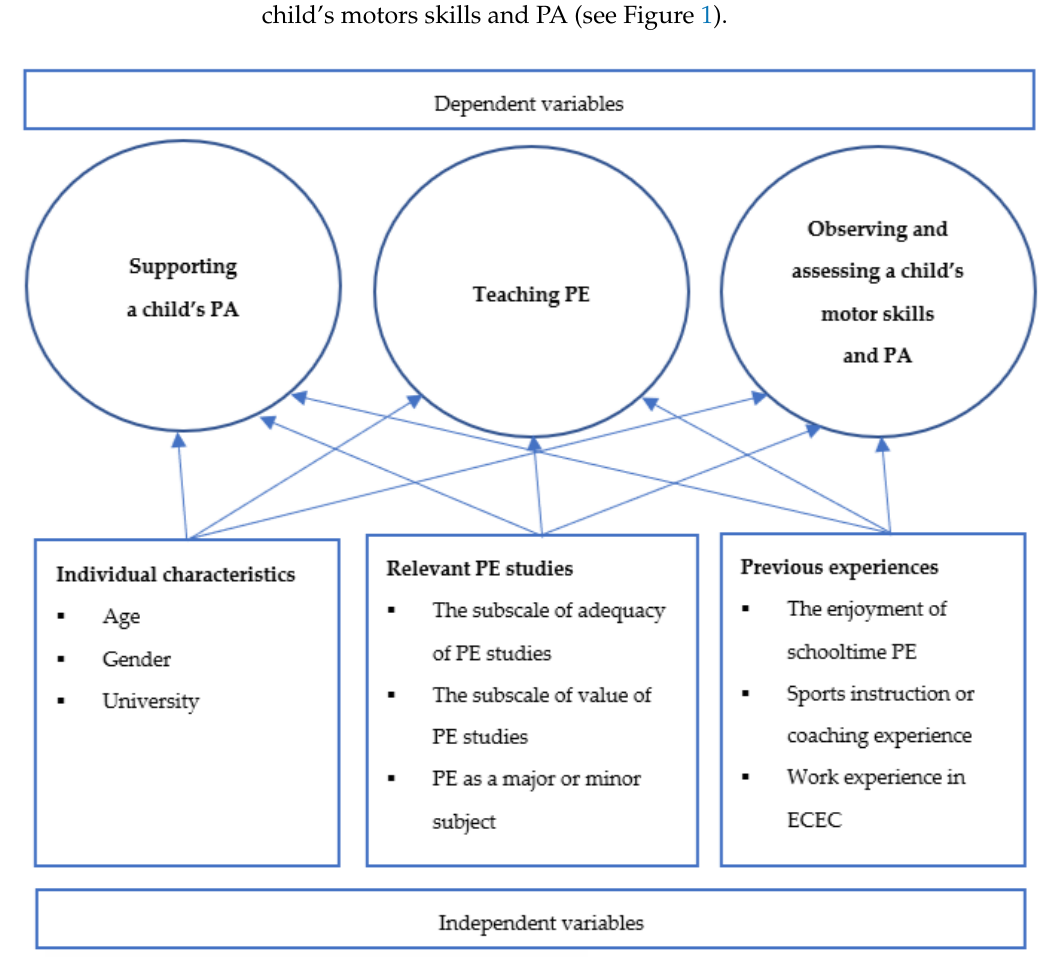
Figure 1. The conceptual model of the variables.